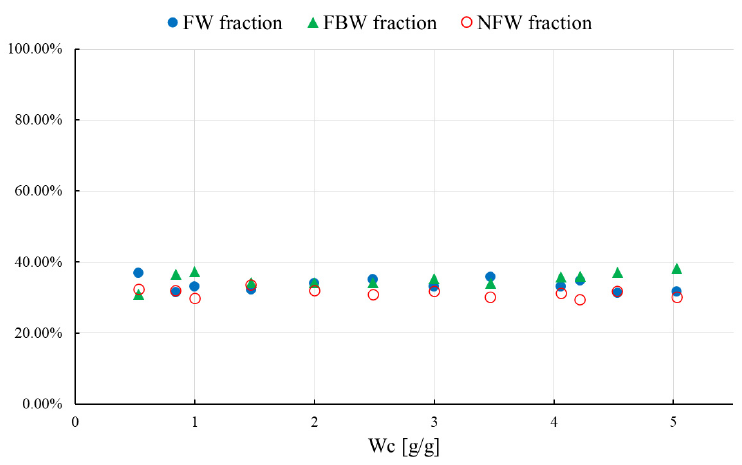
Figure 9. HPC/NaSA mixtures: percentage of the fractions of water in the mixture as a function of water concentration W c . The blue circles indicate the FW fraction, the green triangles the FBW fraction, the red empty circles the NFW fraction.